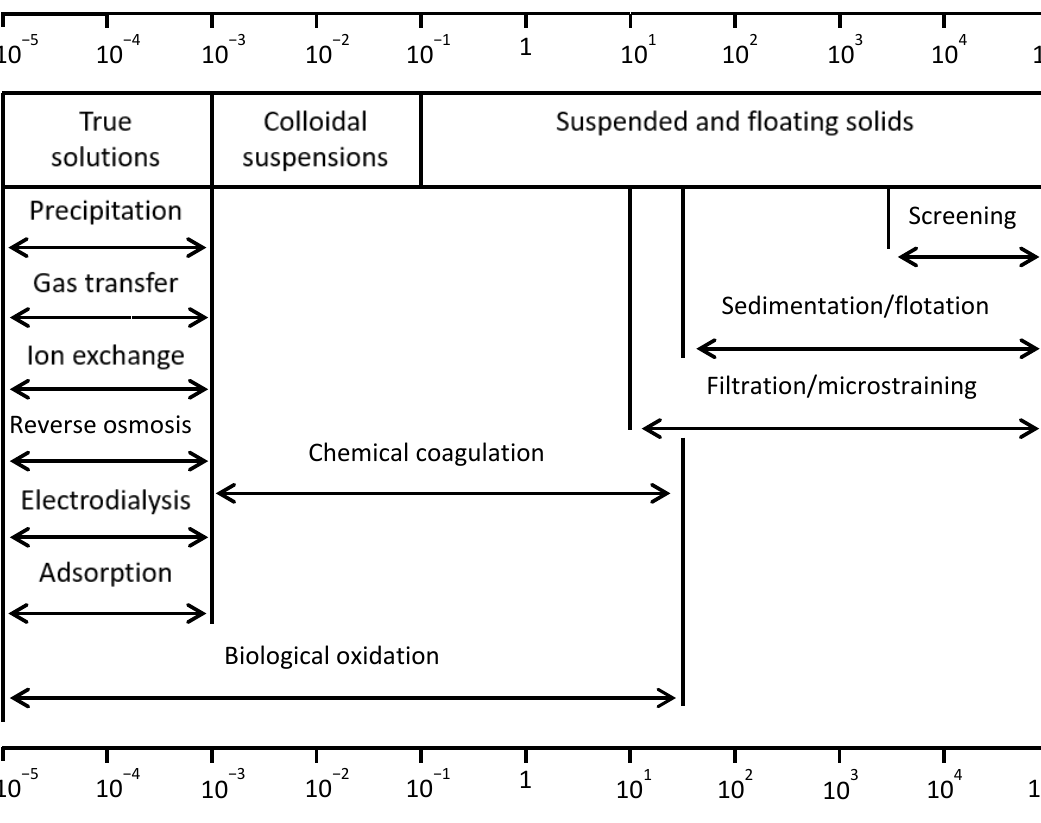
Figure 1. Range of e ff ectiveness of the treatment processes (reprepared using the data from